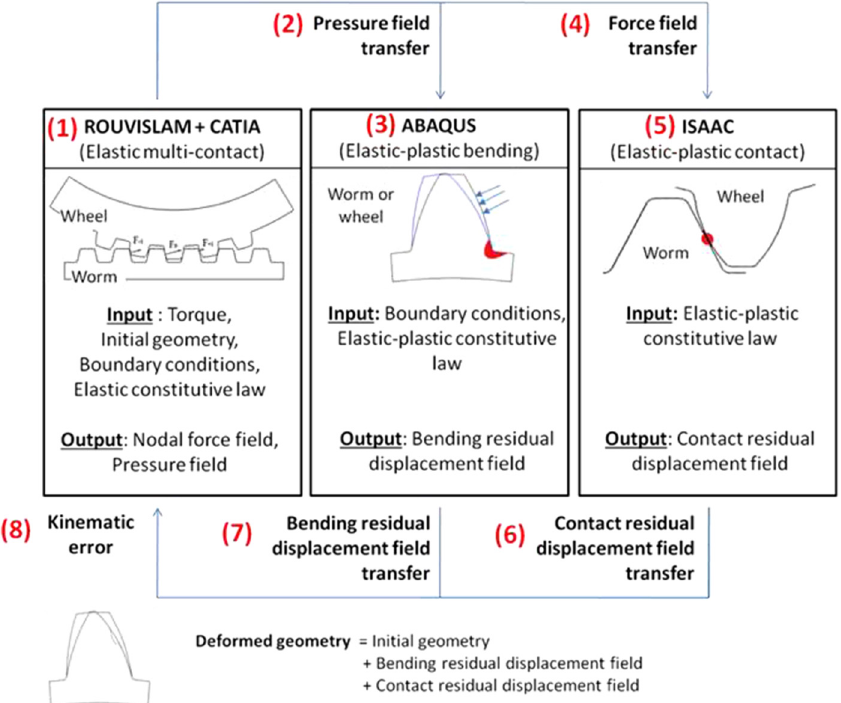
Fig. 2. Diagram for ROUVISLAM – ABAQUS – ISAAC dialogue for the resolution of the elastic – plastic, multi-scale and multi-contact